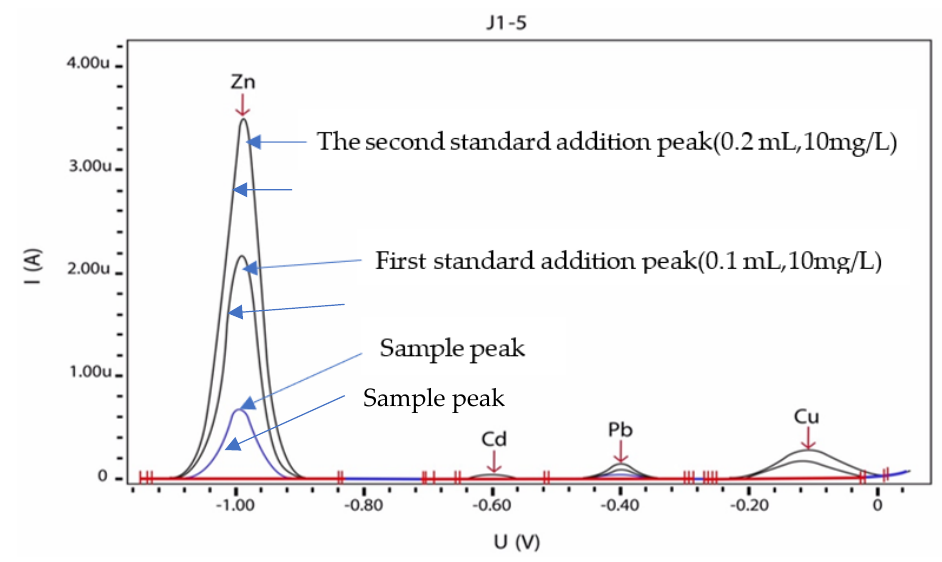
Figure 1. Determination of zinc, cadmium, lead, and copper in sample No. J1-5 and its polarographic curves according to DIN38406/16. Spiked concentrations were 0.1 mL of 10, 0.5, 0.1, and 2.5 mg/L of zinc, lead, cadmium, and copper, respectively.